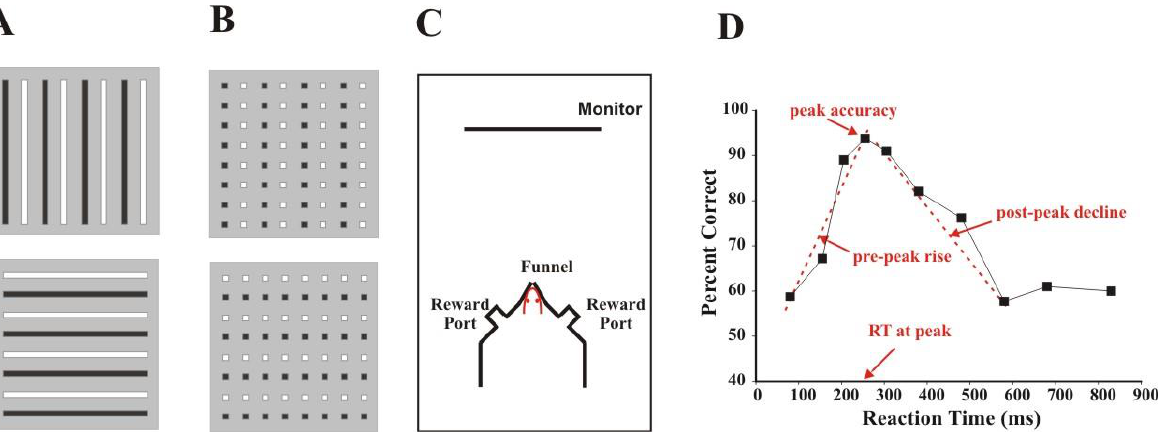
Figure 1 . Vertical and horizontal stimuli for ( A ) solid line and ( B ) grouped dots conditions. C: Top of view of test chamber, indicating central funnel for viewing stimuli on monitor, with approximate position of rat's head, flanked by left and right reward wells associated with response choice. D : Example of data used for statistical analyses. Peak accuracy and RT at peak accuracy are based upon maximum percent correct at each RT bin. Dashed lines depict linear fit to data points preceding and including peak accuracy, and linear fit to data points including and following peak accuracy, extending to asymptotic